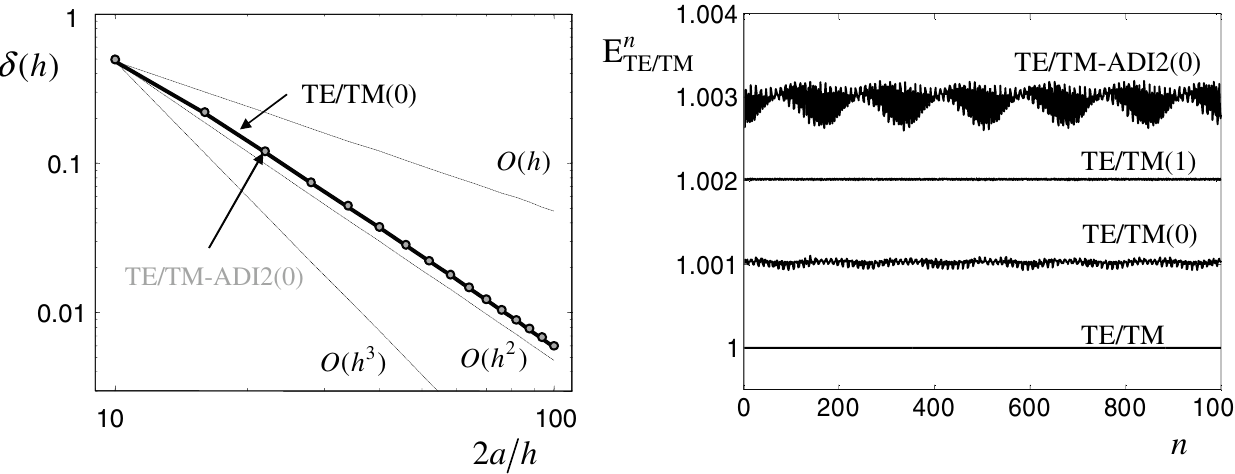
FIG. 4. The left-hand figure shows second order convergence of the TE/TM(0) (solid line) and TE/TM-ADI2(0) schemes for the sphere. The right-hand figure presents conservation of the discrete energy by different methods for 4 (cid:26) (cid:5) 4 z